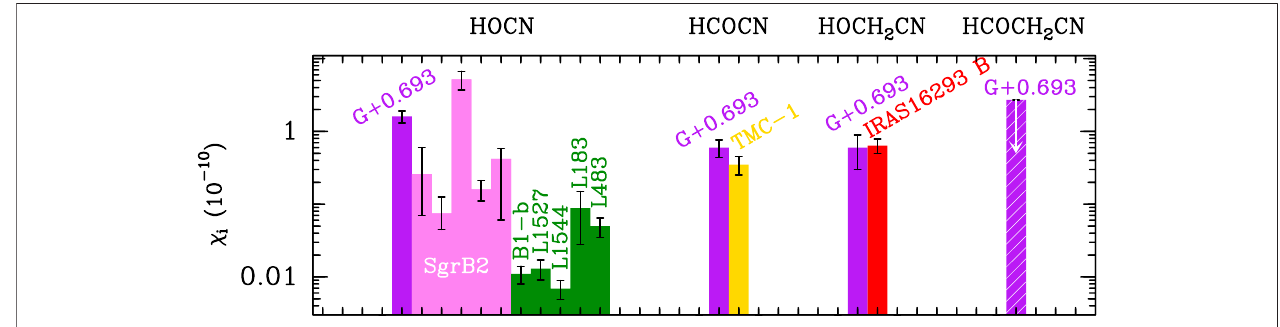
FIGURE 8 | Molecular abundances with respect to H 2 of the oxygen-bearing nitriles studied in this work derived in different interstellar sources. Purple bars correspond to G+0.693 (this work; see Table 4 ), with the HCOCH 2 CN value indicating an upper limit. We compare with other sources: several positions also in the Sgr B2 region (magenta; Brünken et al., 2010, see also Marcelino et al., 2010); several dense cores (B1-b, L1544, L183, and L483) and the lukewarm corino L1527 (green: Marcelino et al., 2010; Marcelino et al., 2018); the dark cloud TMC-1 (yellow; Cernicharo et al., 2021); and the IRAS 16293 – 2422 B hot corino (red, Zeng et al., 2019).Toderivetheuncertaintiesofthemolecularabundanceswehaveconsideredtheuncertaintiesofthemolecularcolumndensitiesreportedinthedifferentworks,or a 15% of the value of N if the uncertainty is not provided, and we assumed an uncertainty for the N (H 2 ) column densities of 15%.